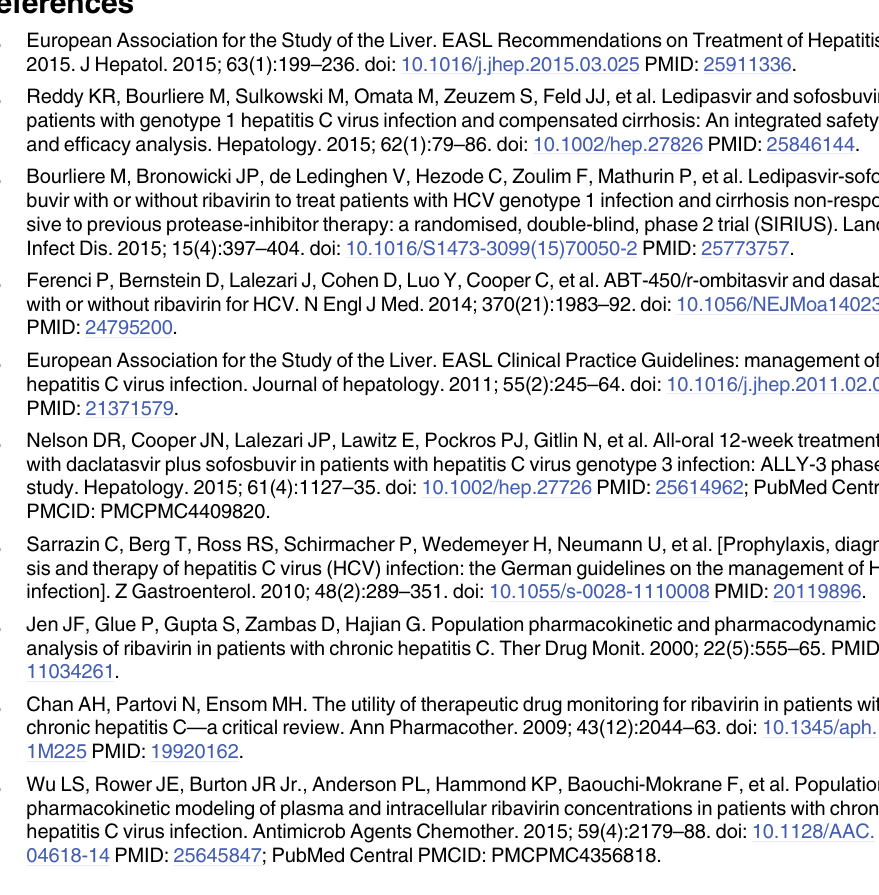
S1 Table. Ribavirin_Data. Raw data analyzed for this